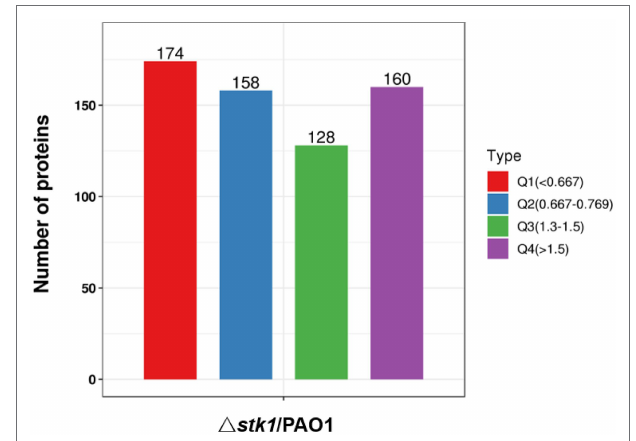
FIGURE 7 | Differentially expressed protein groups based on their differential expression